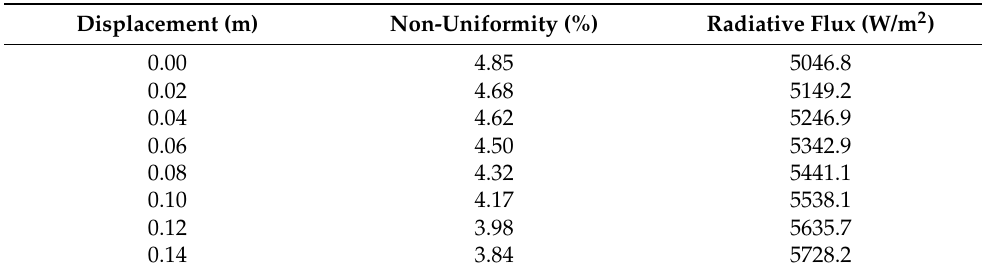
Figure 7. ( a ) Average radiative flux at the receiver; ( b ) non-uniformity for 13 different concentration ratios. To visualize the non-uniformity improvement, Table 4 shows the non-uniformity and average radiative flux variation when the receiver’s displacement increases until minimum uniformity is reached. The analysis was performed for the best-case scenario, C = 13.0, with f 1 = 0.445 m and f 2 = 0.032 m. Table 4. Non-uniformity and average radiative flux at the receiver by incrementing its displacement for the best-case scenario: C = 13.0, W a1 = 1.62 m, f 1 = 0.445 m, f 2 = 0.032